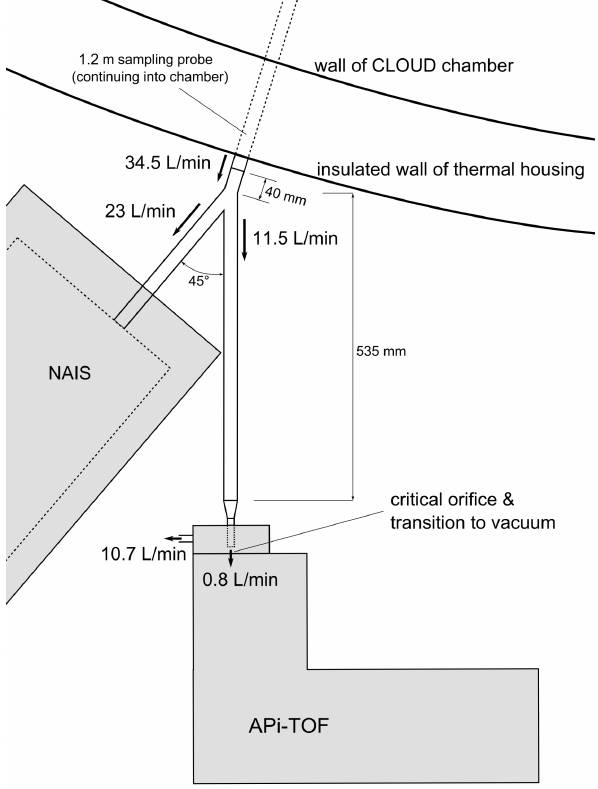
Figure 1. Setup of the APi-TOF at the CLOUD chamber during the CLOUD 2 and CLOUD 3 campaigns. The APi-TOF shared one sampling probe (22.1mm ID) with the NAIS. The flow was split via a Y-splitter. Before reaching the critical orifice inlet of the APi- TOF, the inner tube diameter reduced from the Y-splitter’s 21.2mm to